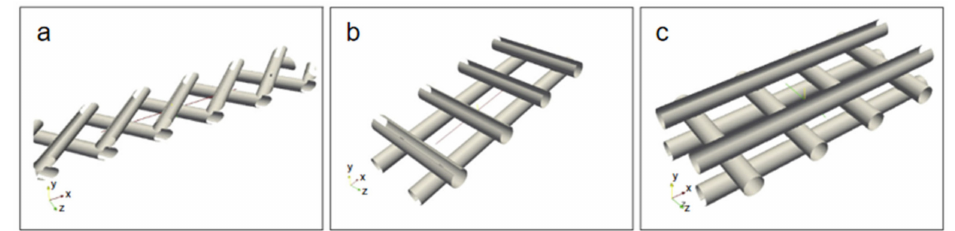
Figure 15. Spacer geometries [33]. Reproduced with permission from Elsevier, 2013. ( a ) spacer type 1; ( b ) spacer type 2; ( c ) spacer type 3.